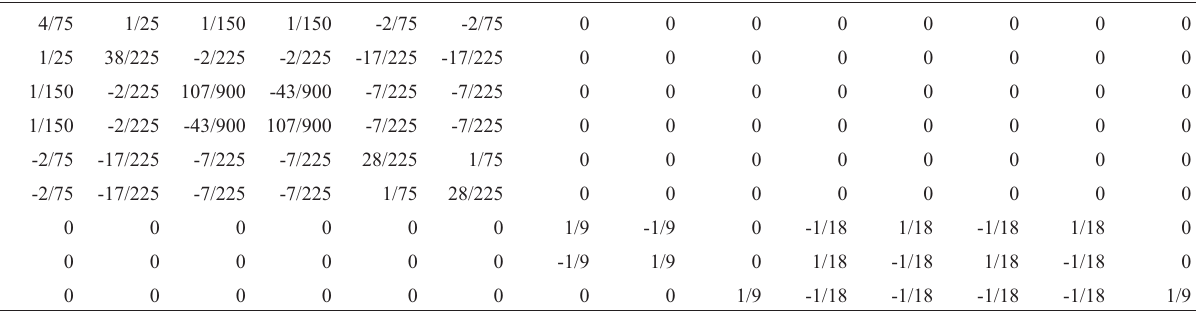
Table 12 - Estimates of the variances and covariances of the effects for an incomplete diallel model (Case 2, type 1 constraints) calculated using a matrix